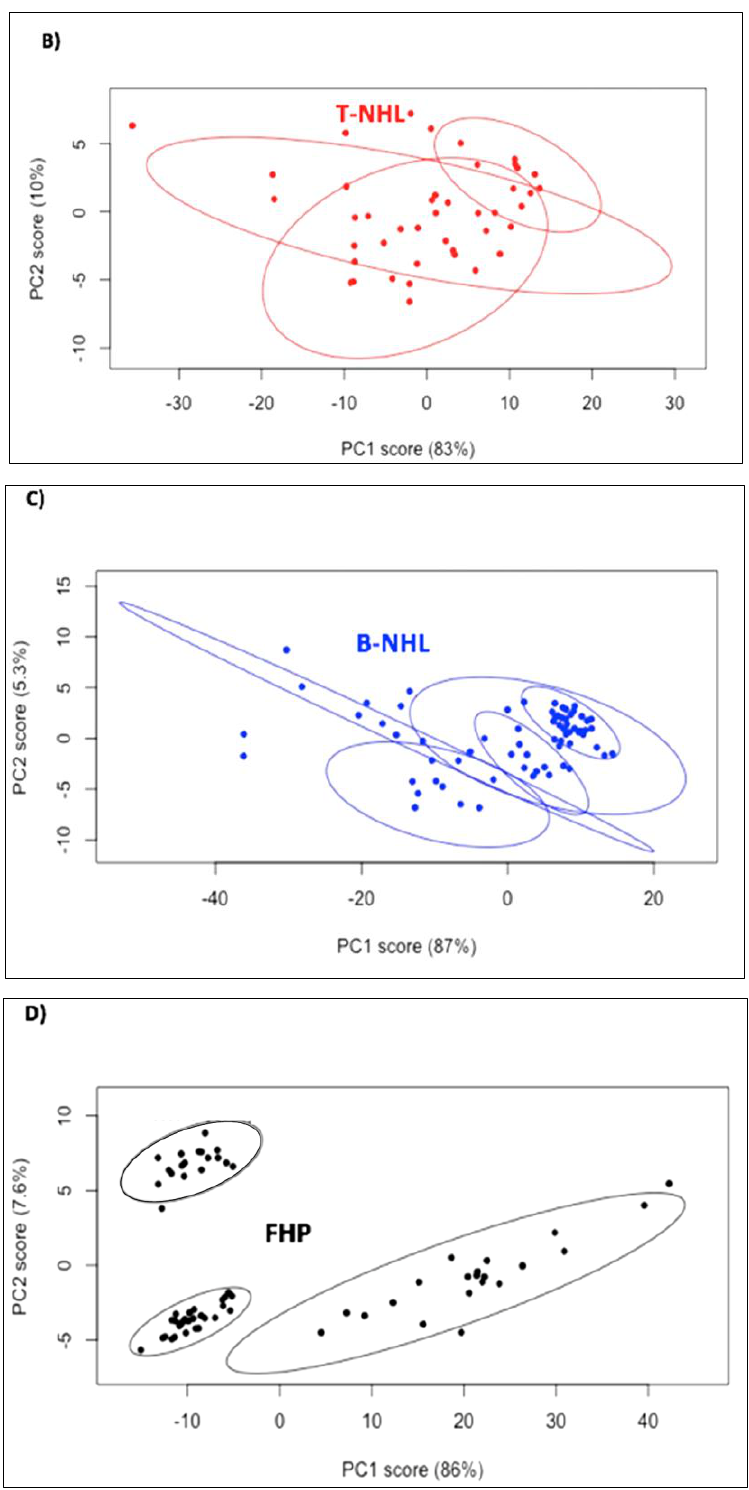
Figure 1. Raman spectroscopy (RS) peaks and Principal Component Analysis (PCA) plots of all NHL specimens categorized into T-cell NHL (T-NHL), B-cell NHL (B-NHL), and follicular hyperplasia (FHP). A) Averaged RS peaks from T-NHL, B- NHL, and FHP highlighting the 1350-1400 cm -1 region; B) PCA of NHL subtypes belonging to T-NHL; C) PCA of NHL subtypes belonging to B-NHL; D) PCA of FHP